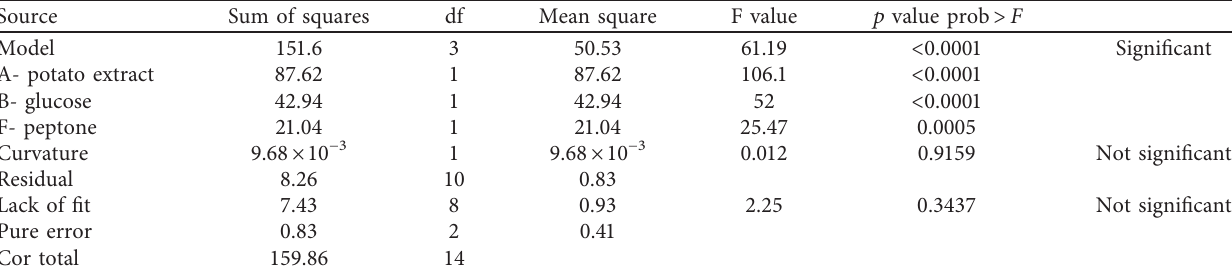
Table 5: Variance analysis results of the Plackett–Burman